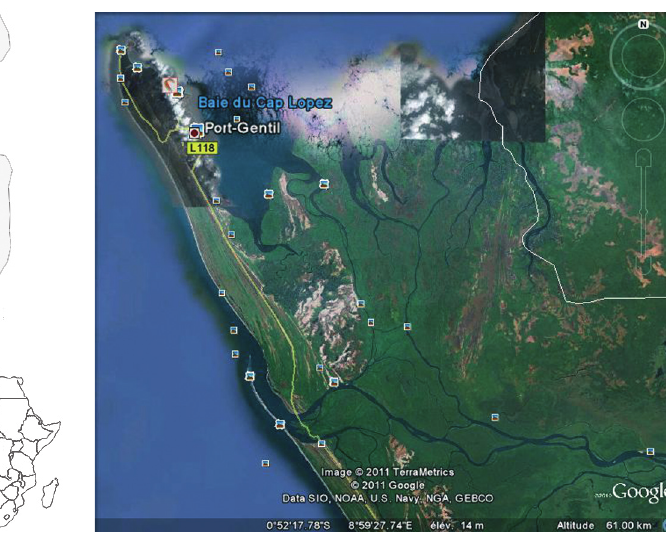
de l’Ogooué-Maritime.